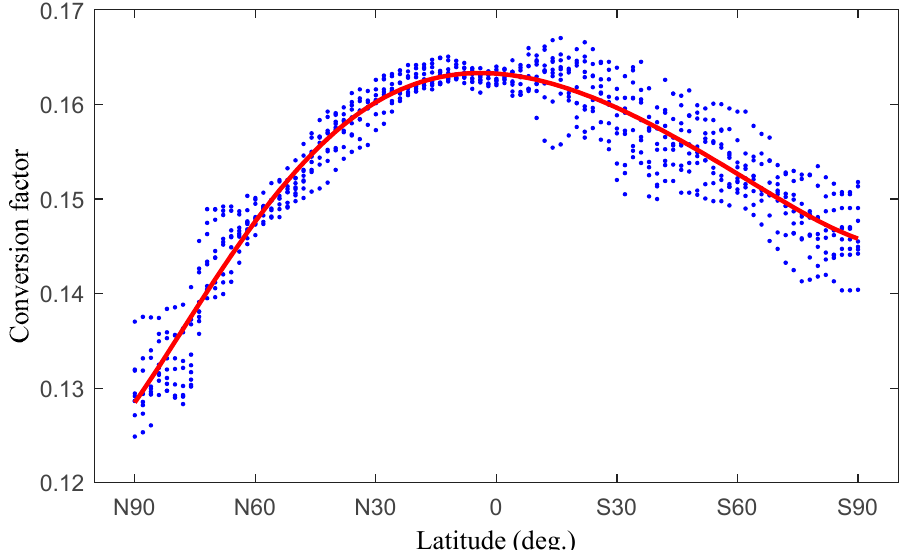
Figure 5. Relationship between the conversion factor and the latitude using the data of grid points globally from the year 2013.